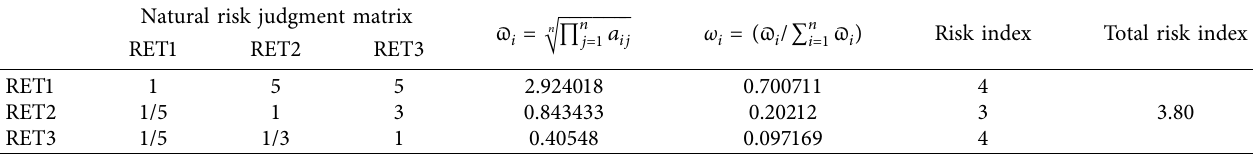
Table 43: Natural risk judgment